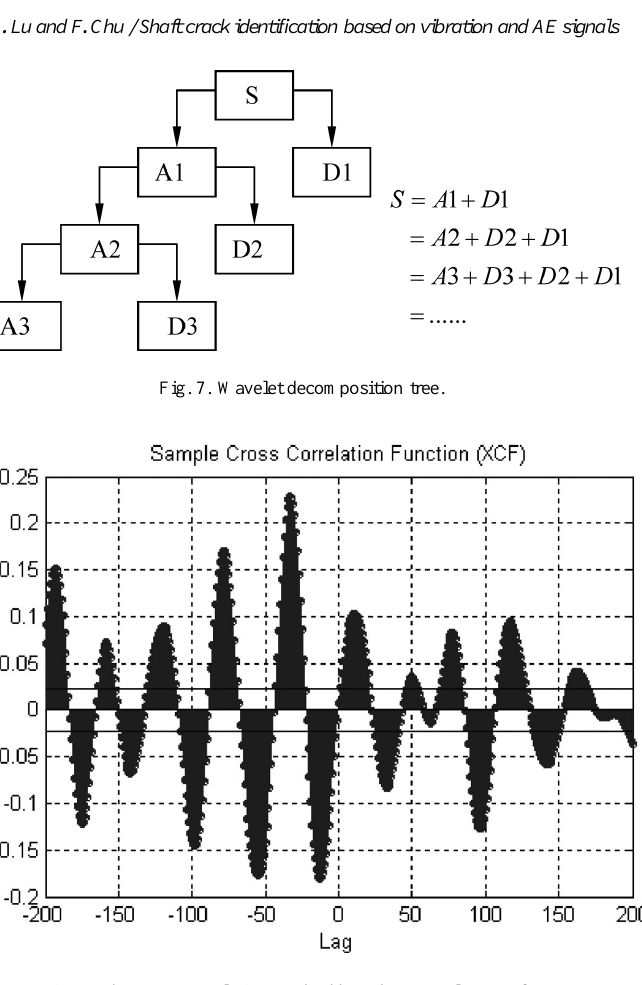
Fig. 8. The cross-correlation method based on wavelet